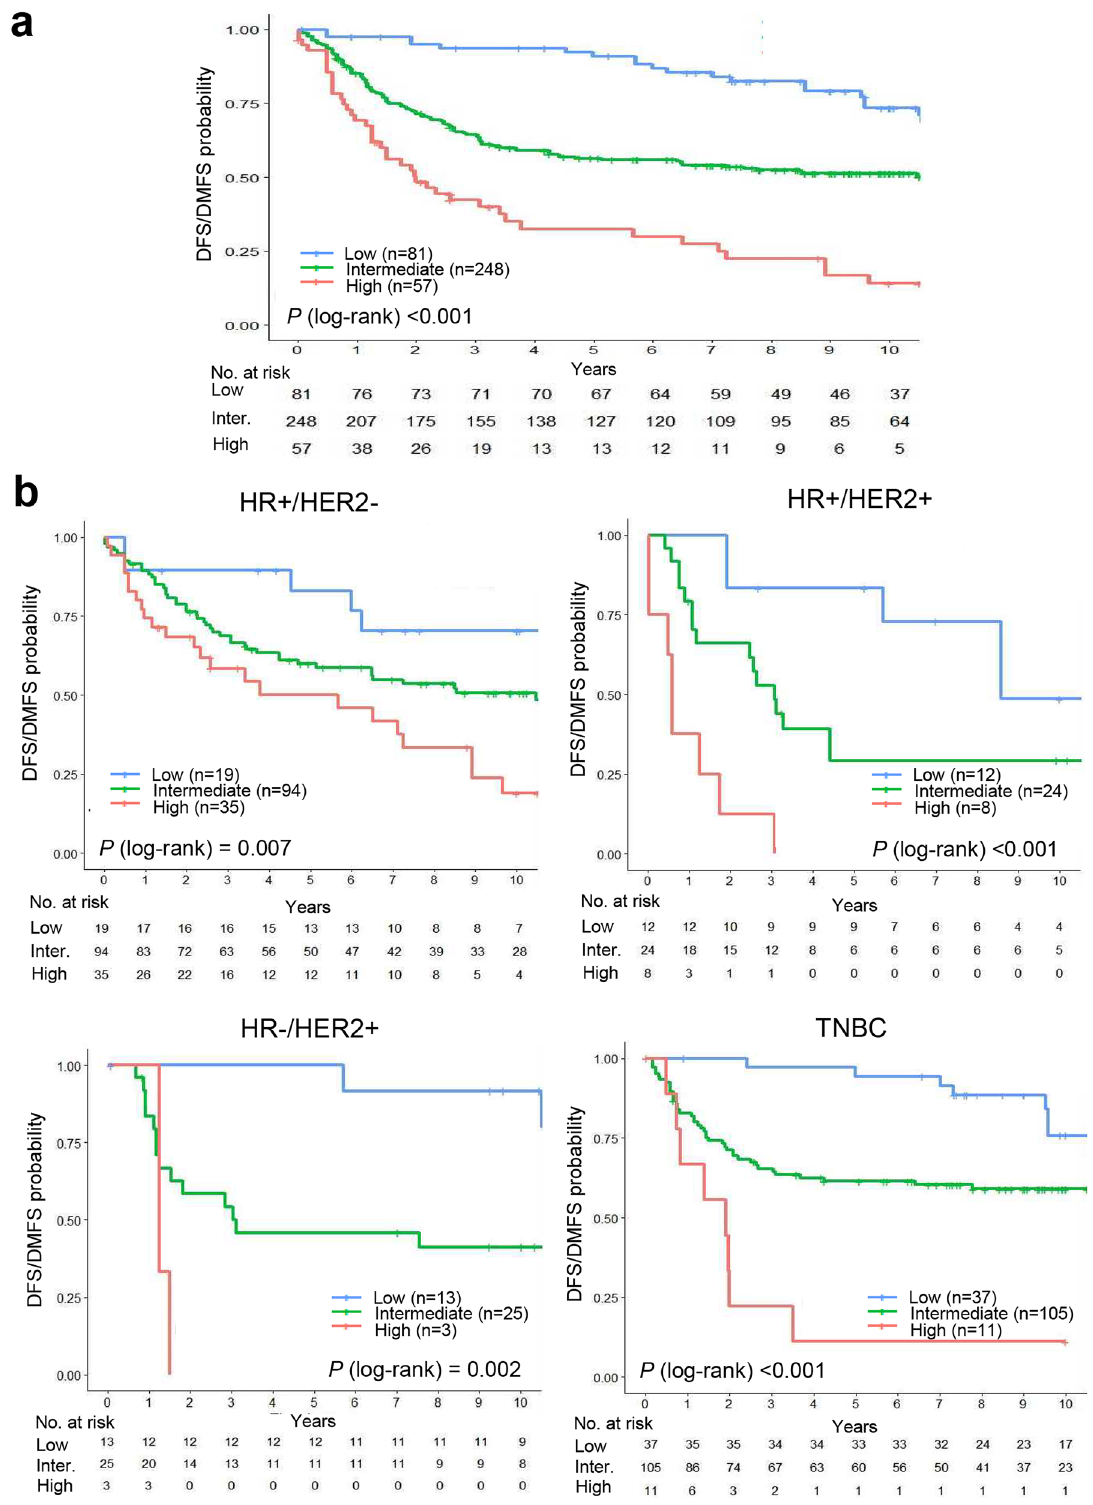
Figure 2. Kaplan–Meier plots of disease-free survival (DFS) or distant metastasis-free survival (DMFS) in the clinical and proliferation high-risk (CPH) group within the discovery dataset. ( a ) Total population and ( b ) subgroup analysis according to the molecular subtype (HR+/HER2−, HR+/HER2+, HR−/HER2+ breast cancer and TNBC). Patients were classified into three risk groups according to the immune prognostic index. Optimal cutoff points for the immune prognostic index used for risk classification were determined using maximally selected rank